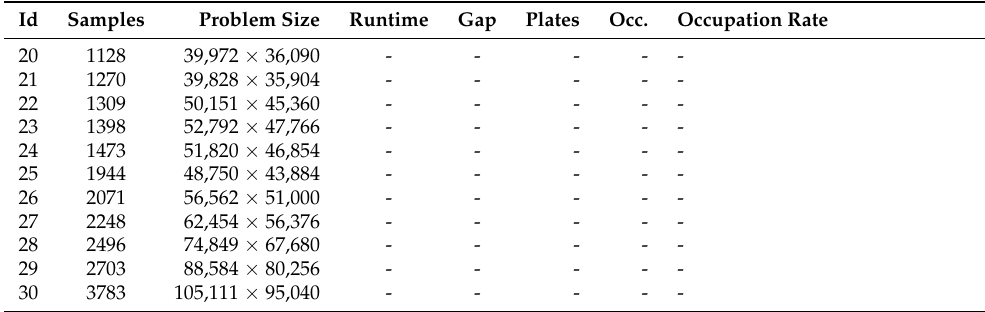
Table A7. ILP1 results obtained for big size files, limited to 600s. No solutions have been found in